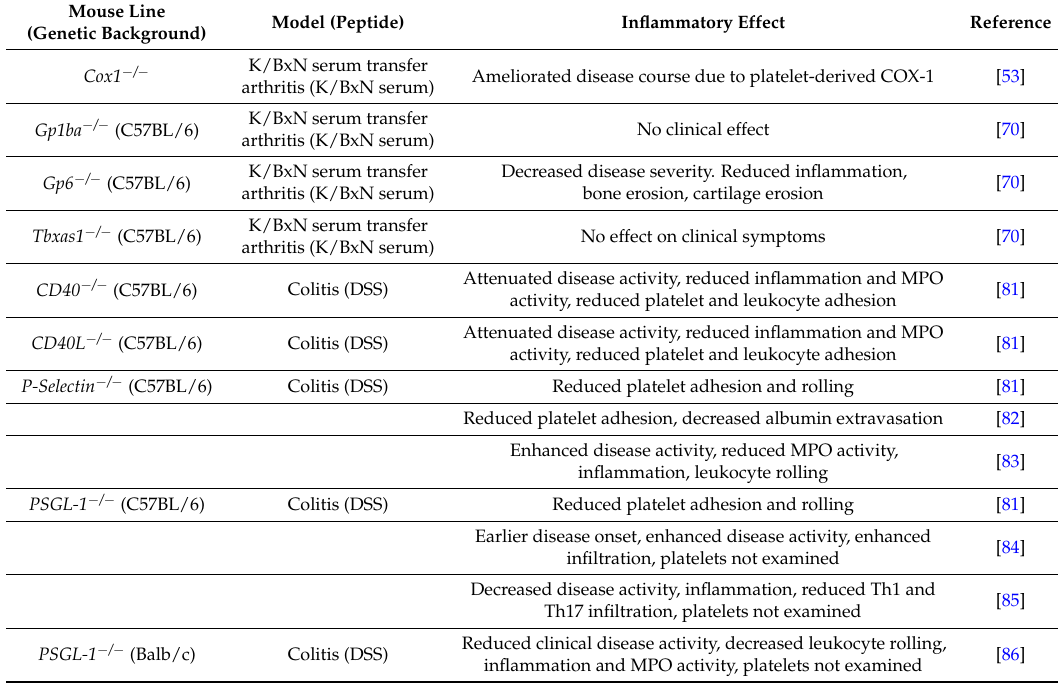
Table 3. Studies of platelets and platelet-derived factors: effects on inflammatory processes in transgenic